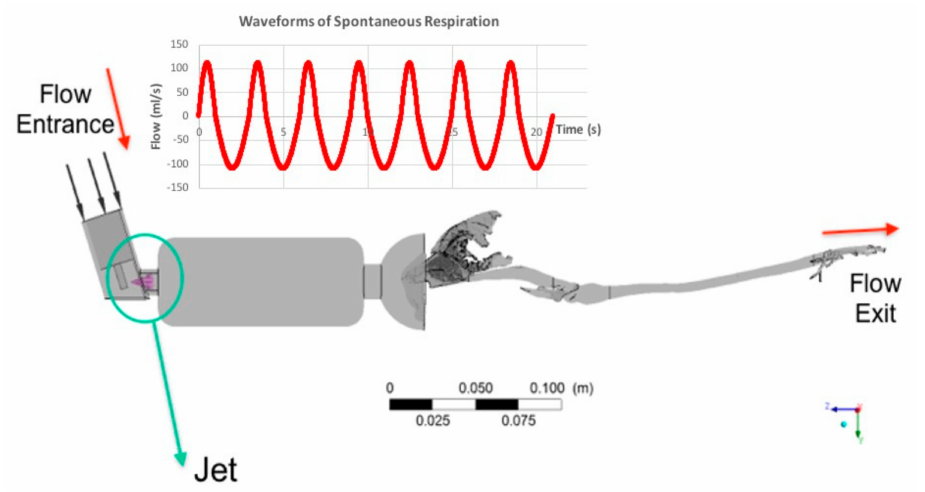
Figure 4. Pressurized metered-dose inhaler (pMDI) connected to a 10 cm spacer and a spherical preoxygenation mask model. Red arrows represent flow direction. Waveforms of spontaneous respiration are plotted in red in the upper part of the figure. The green circle and arrow highlight the location of the spray (in purple), nozzle orifice, and point of particle injection with a jet velocity of 150